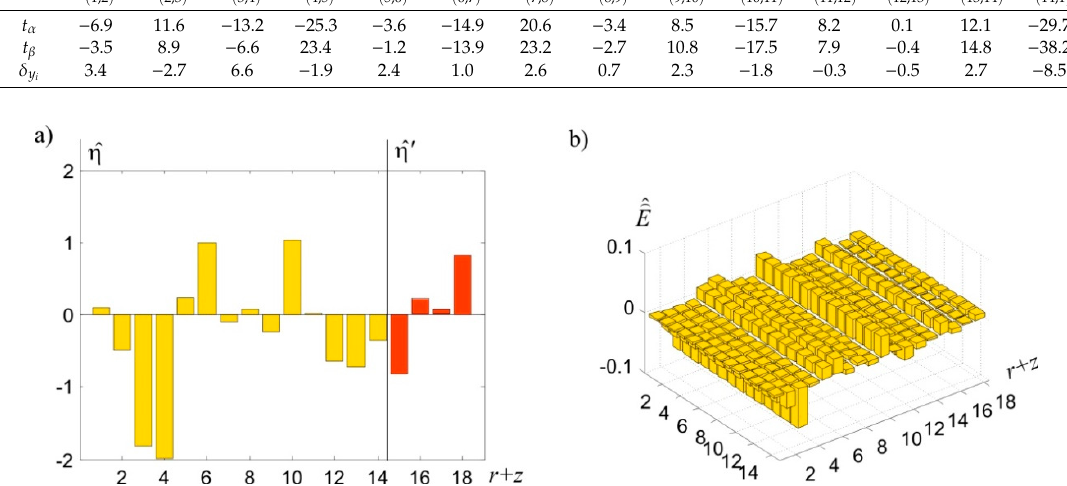
Figure 8. Graphic illustration of ( a ) random displacement and ( b ) surface noise.